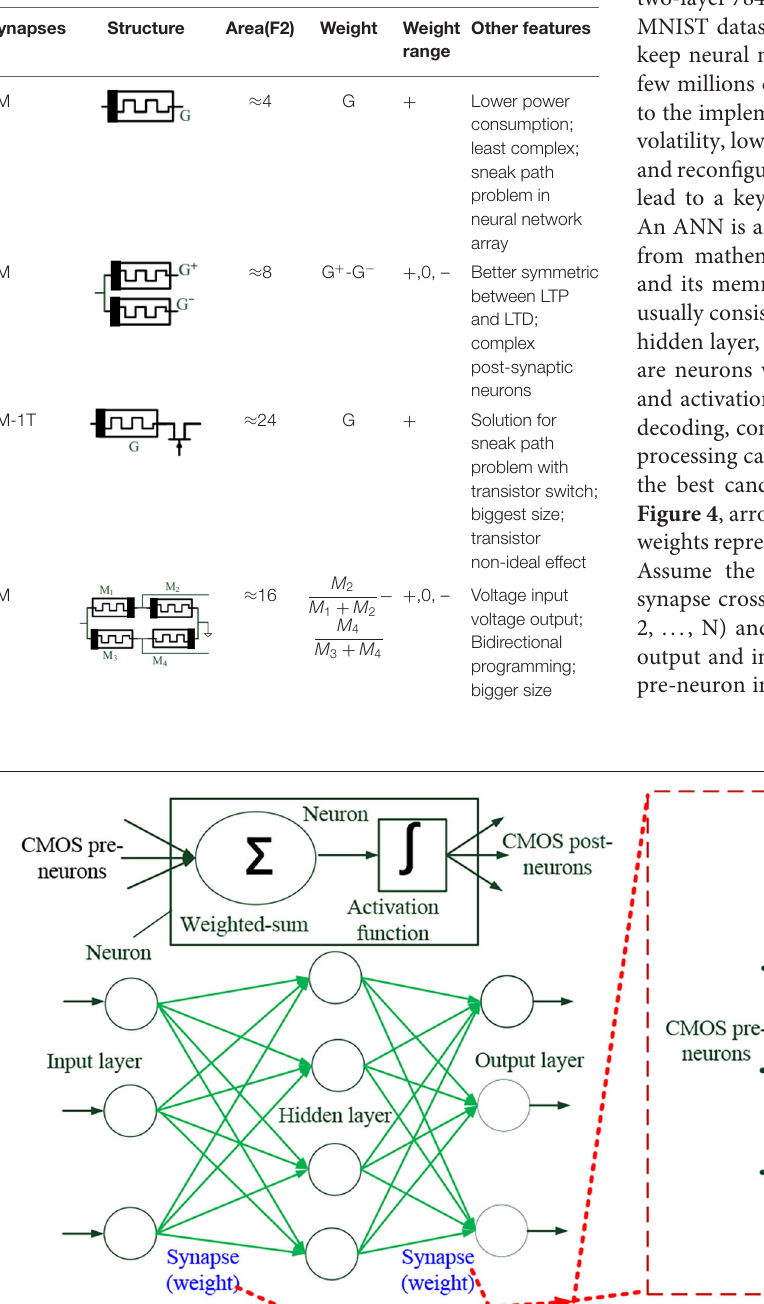
FIGURE 4 | Typical ANN architecture and its memristor